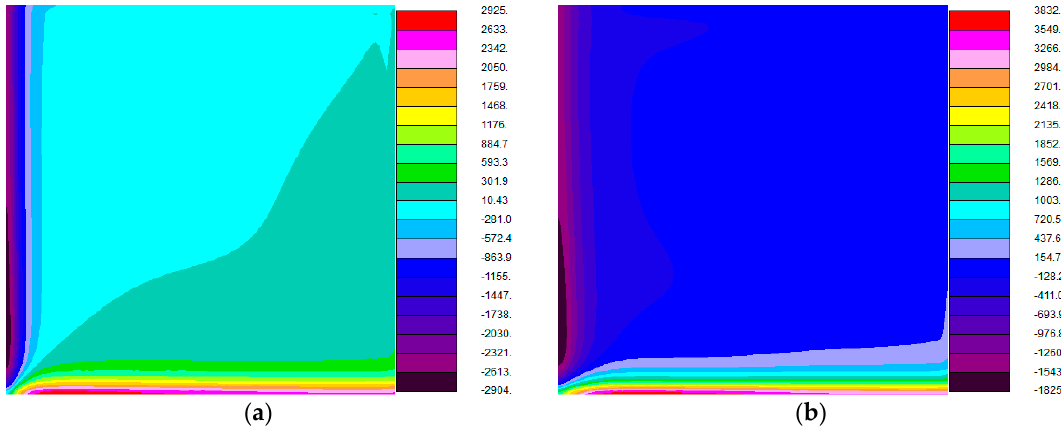
Figure 11. The plate LHC heat flux distributions of cross-flow plate heat exchanger heat transfer model with LHC ( a ) Balanced flow; ( b ) Unbalanced flow.